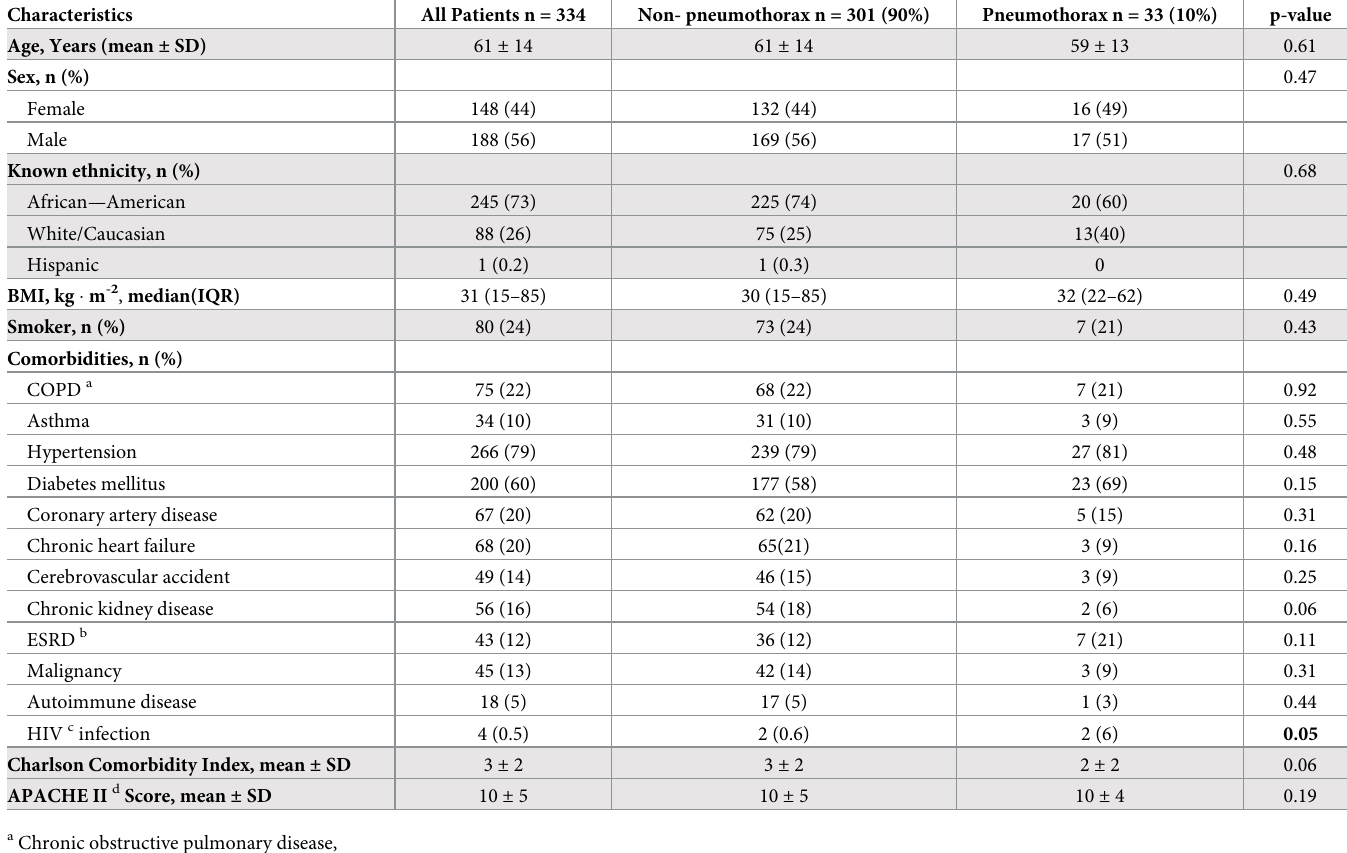
Table 1. Subjects